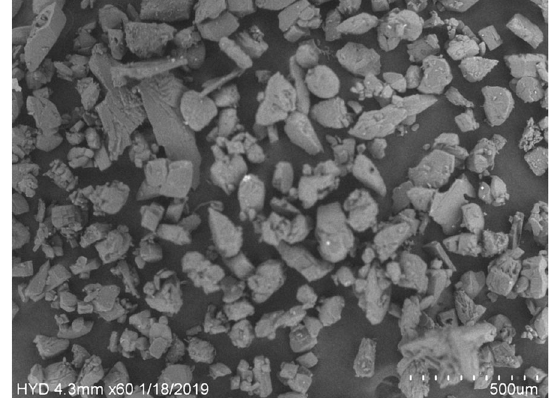
Fig. 14 SEM image of 0.065 g/ml methanol obtained from cooling method. Process conditions: 6 h with no stir (×